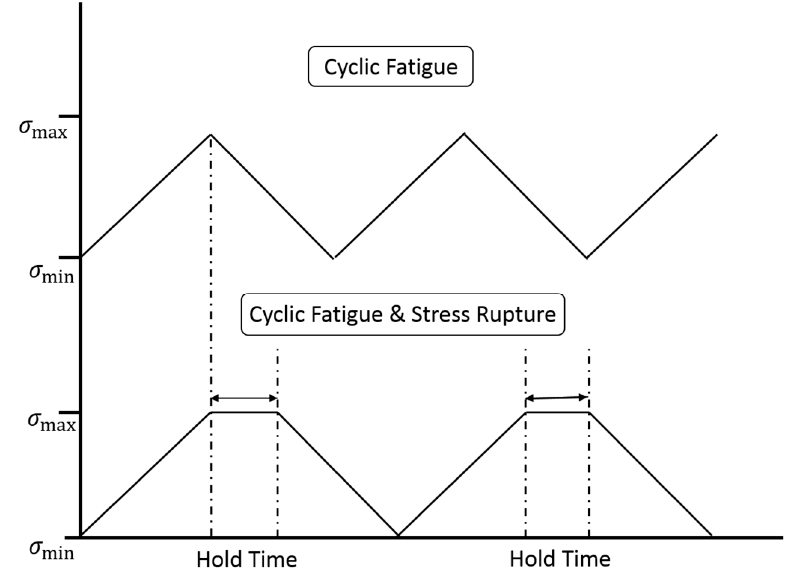
Figure 4. The schematic of cyclic fatigue loading and cyclic fatigue loading with hold time.